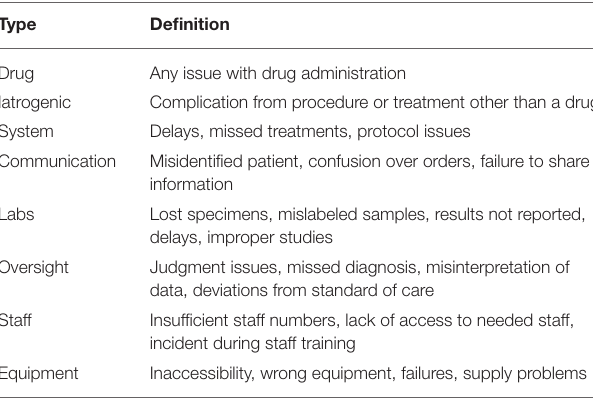
TABLE 1 | Error types and their definitions in the incident reporting system.